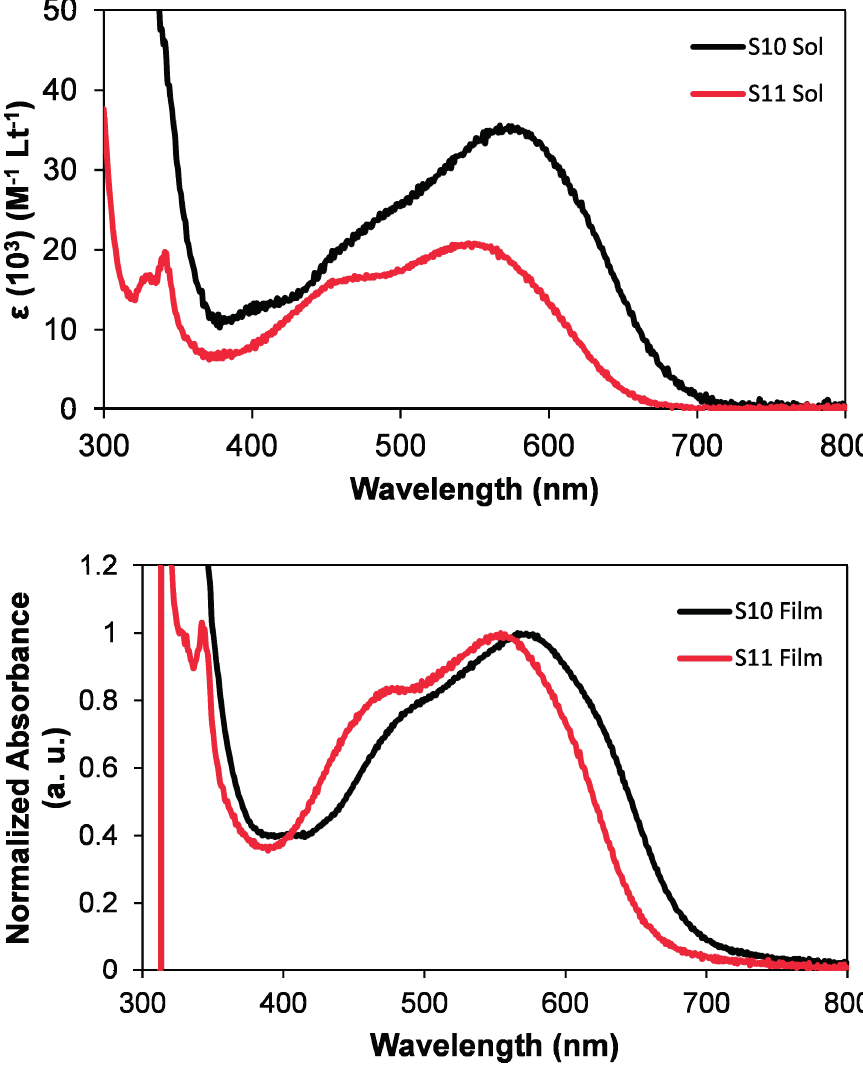
Figure 2. Molar absorptivity of newly synthesized materials S10 and S11 in chloroform solutions (upper) and normalized UV–Vis absorption spectra of S10 and S11 in thin solid films (lower), spin-cast from their chloroform solutions (equimolar solutions of S10 and S11 spun at 2500 rpm for 1